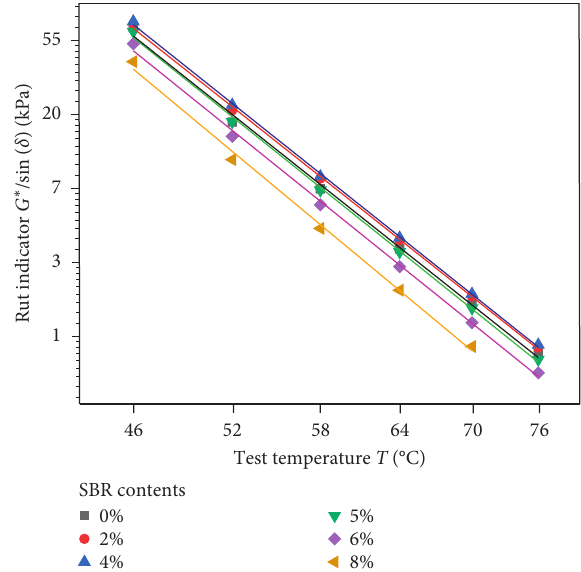
Figure 8: The variation patterns of rutting indicators and test temperatures. Table 6: Fitting results of G ∗ /sin ( δ ) with test